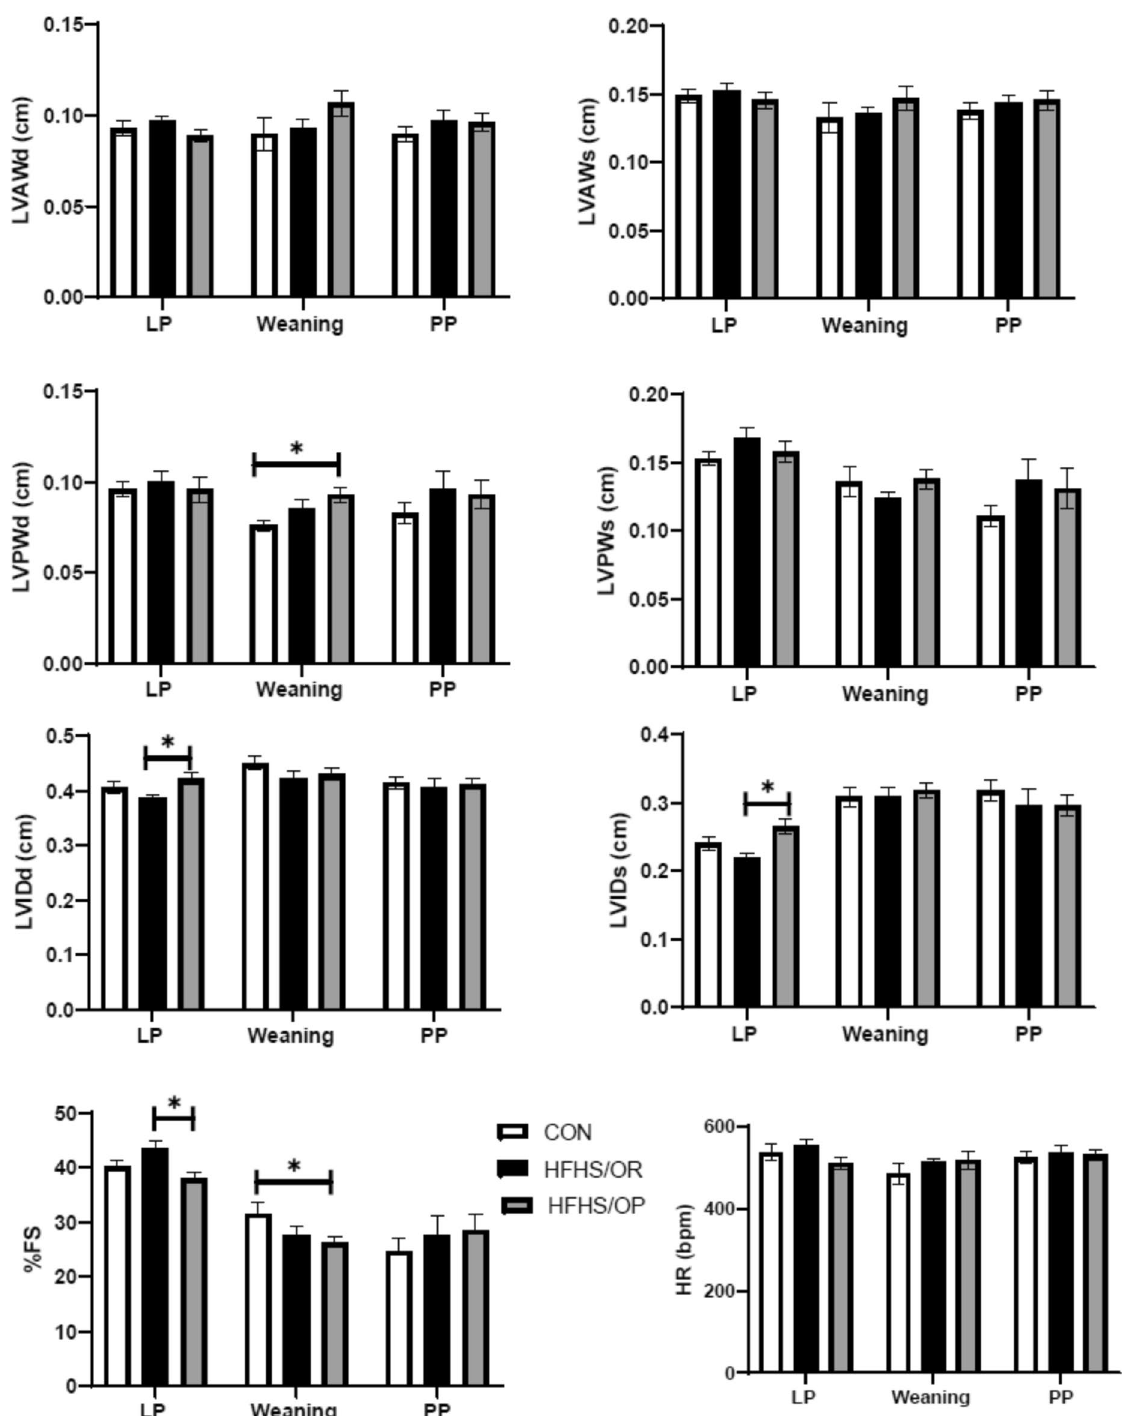
Figure 3. Cardiac function measured by M-mode Echocardiography. Cardiac function was not altered by the diet or obesity during postpartum although decreased cardiac function was observed at LP and weaning. Echocardiography was done at 1 to 2 days before parturition (LP), at weaning (21 days after delivery), and 6 weeks postpartum. CON, control diet; HFHS, obese-resistant mice fed with a high-fat and a high-sucrose diet; HFHS/OP, obese prone mice fed a high-fat high-sucrose diet. The data were shown together for easy to acquire and not for the comparison among different measurement phases. Values are expressed as mean ± SEM; n = 7–11/group. Statistical significance is calculated by one-way ANOVA. LVAWd, left ventricular anterior wall at diastole; LVIDd, left ventricular interior dimension at diastole; LVPWd, left ventricular posterior wall at diastole; LVAWs, left ventricular anterior wall at systole; LVIDs, left ventricular interior dimension at systole; LVPWs, left ventricular posterior wall at systole; % FS, percent fractional shortening. CON, white bars; HFHS/ OR, black bars; HFHS/OP, gray